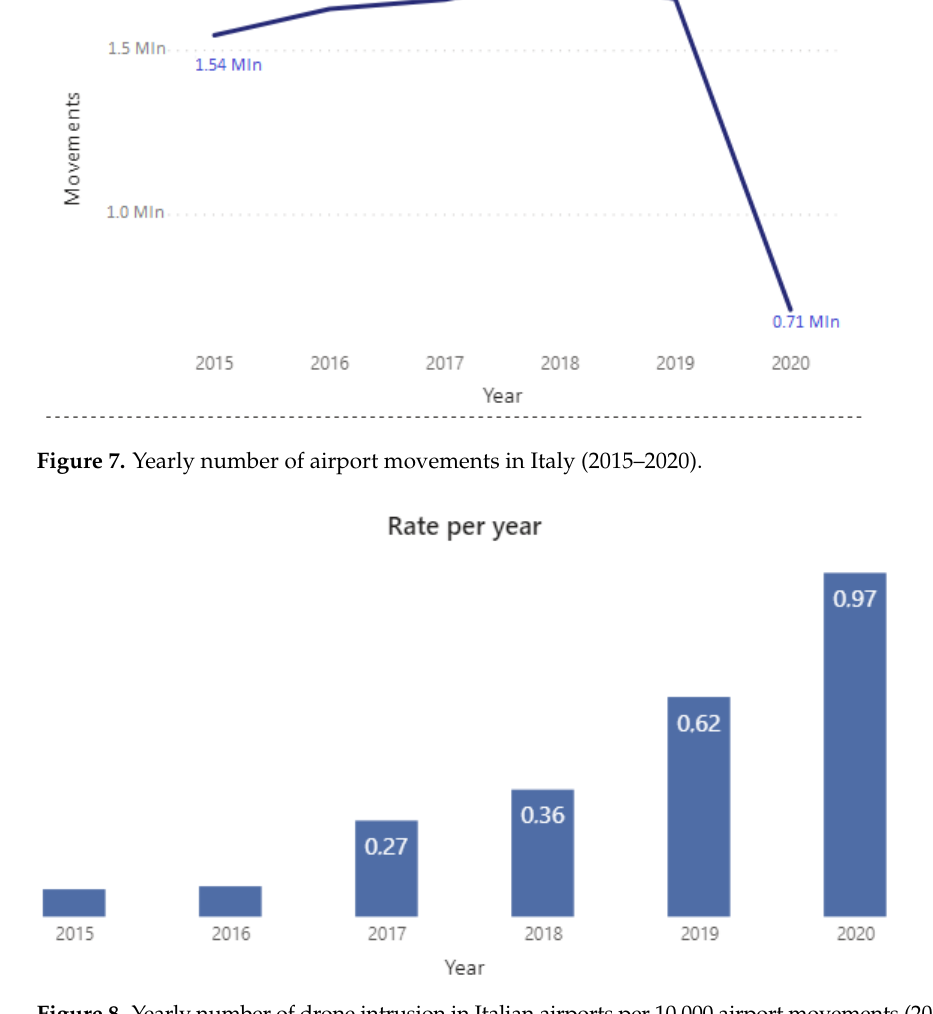
Figure 8. Yearly number of drone intrusion in Italian airports per 10,000 airport movements (2015– 2020).